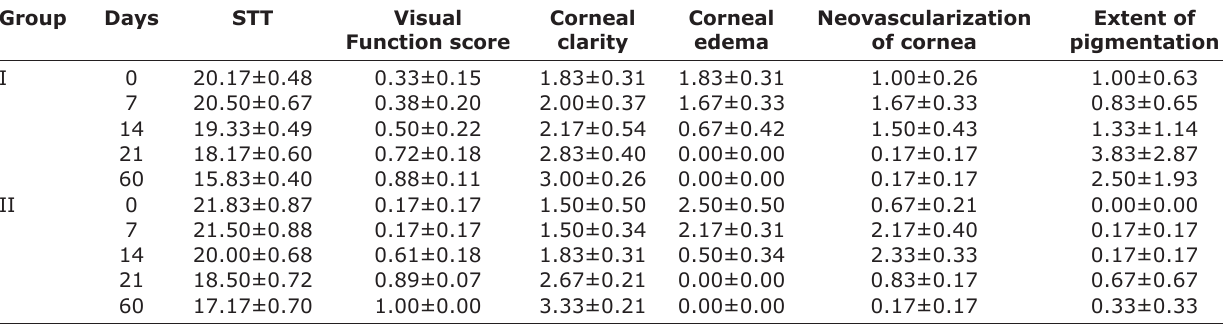
Table-3: The mean values of aqueous tear production (STT) and corneal grading factors including visual function score, corneal clarity, corneal edema, neovascularization of cornea and extent of pigmentation (mean±S.E) recorded on the day of presentation and on days 7, 14, 21, and 60 postoperatively in both Group I and Group II animals. Group Days STT Visual Corneal Corneal Neovascularization Extent of Function score clarity edema of cornea